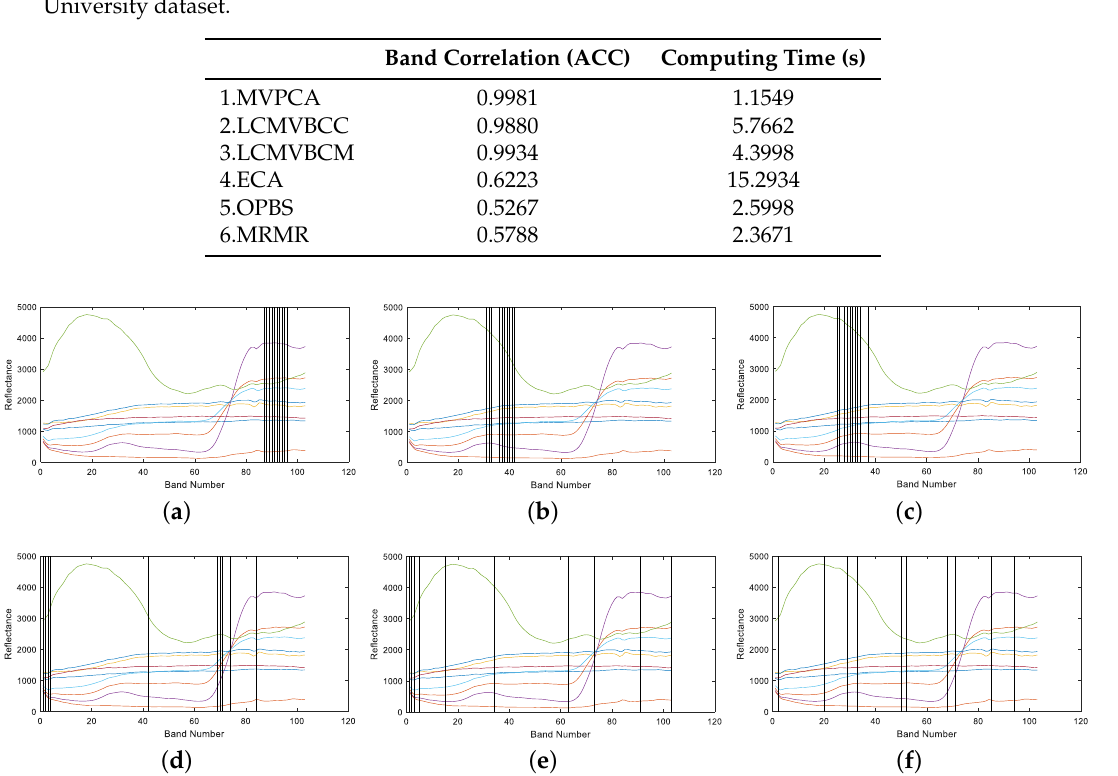
Table 4. Average band correlation and computing time for selecting fifteen bands from the Pavia University dataset.